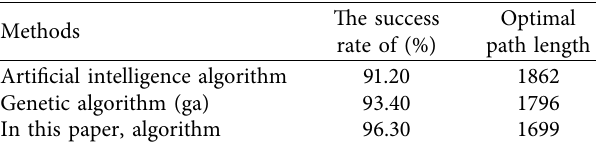
Table 3: Performance comparison of ship route planning with diferent